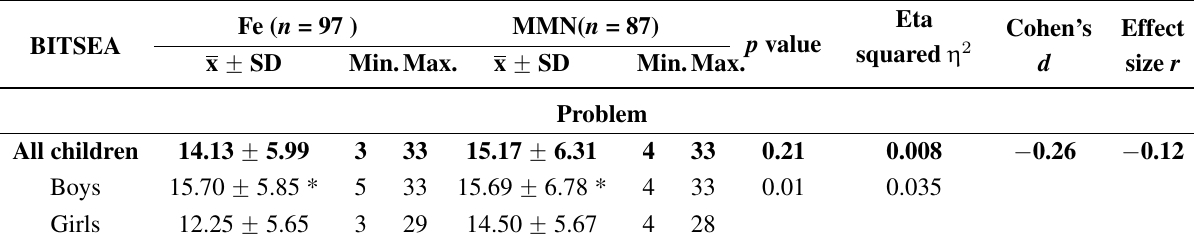
Table 3. Behaviour outcome: BITSEA test, problem and competence scores, by group and